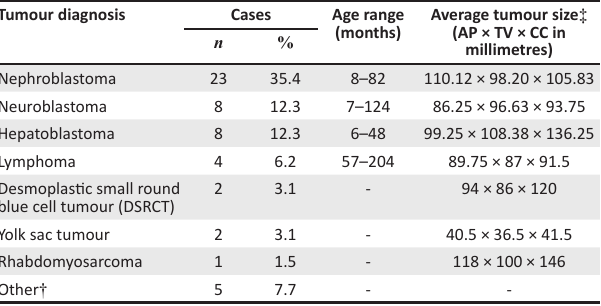
TABLE 3: Histologically confirmed malignant